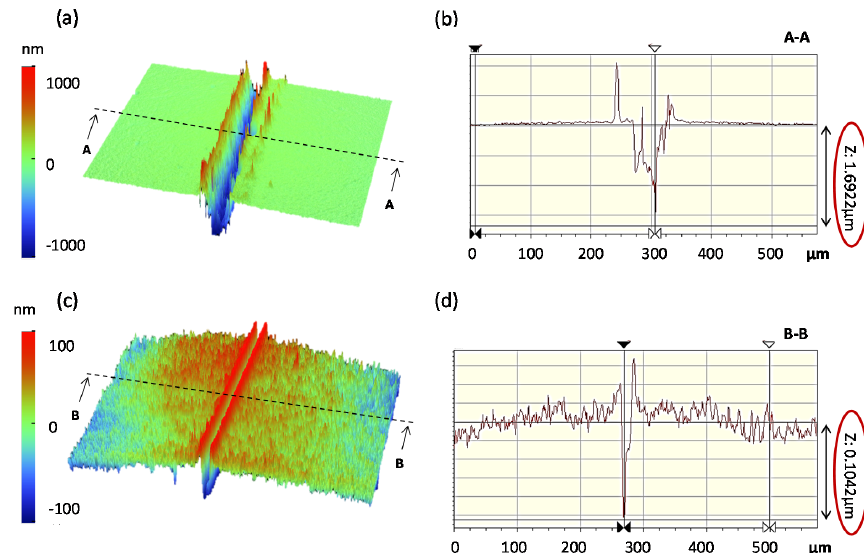
Figure 6. Veeco analysis of the surface at disc regions of low and high emission, ( a ) 3D profile at 270°; ( b ) section depth at 270°; ( c ) 3D profile at 90°; ( d ) section depth at 90°.